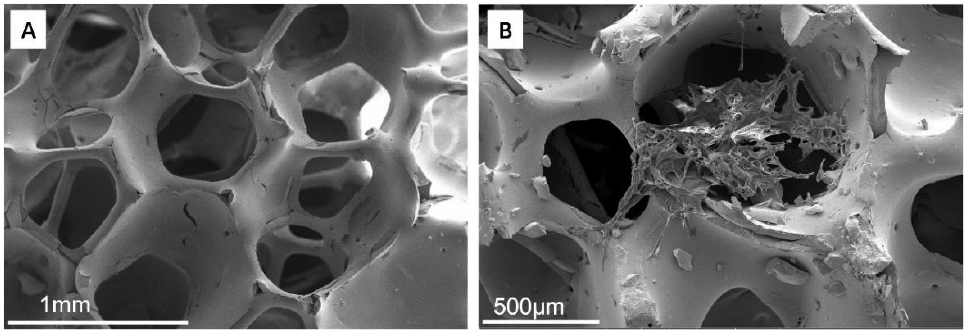
Figure 3. SEM images of porous zirconia matrix and ZrO 2 – chitosan composite scaffold . ( A ) porous ZrO 2 matrix; ( B ) ZrO 2 – chitosan composite